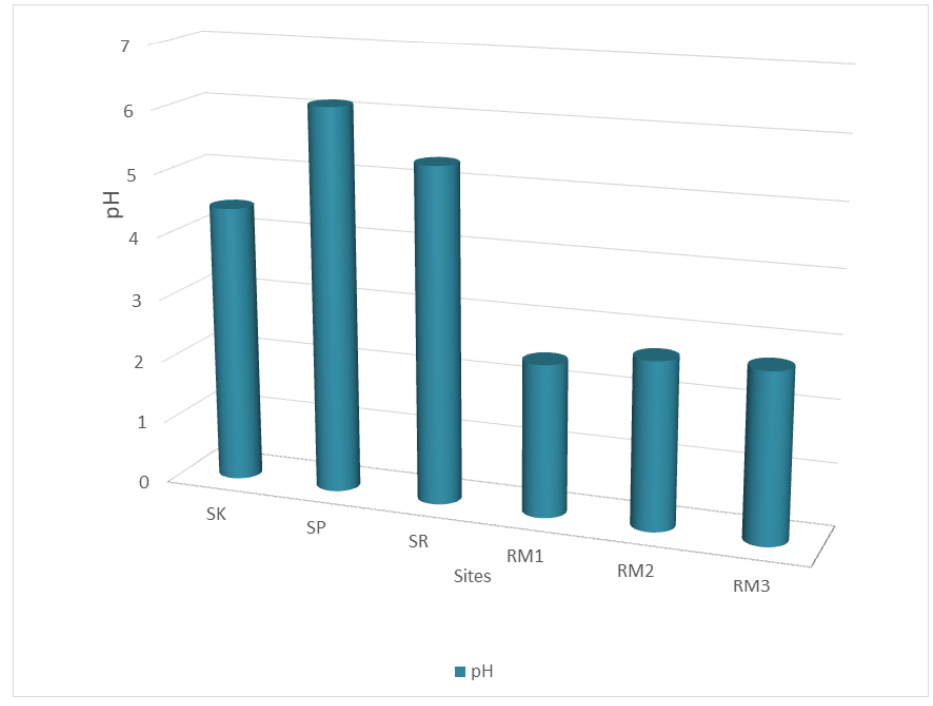
Figure 4. Comparison of pH among samples taken from Royal Belum Reserved Forest and Raja Muda Musa Peat Swamp Reserved Forest .